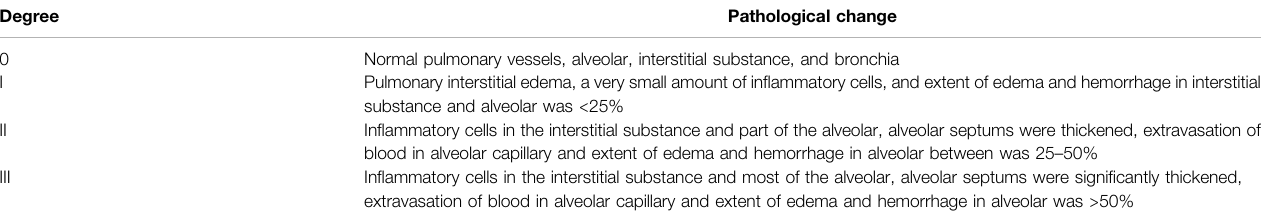
TABLE 2 | The degree of pathological change in rat lung tissues. Degree Pathological